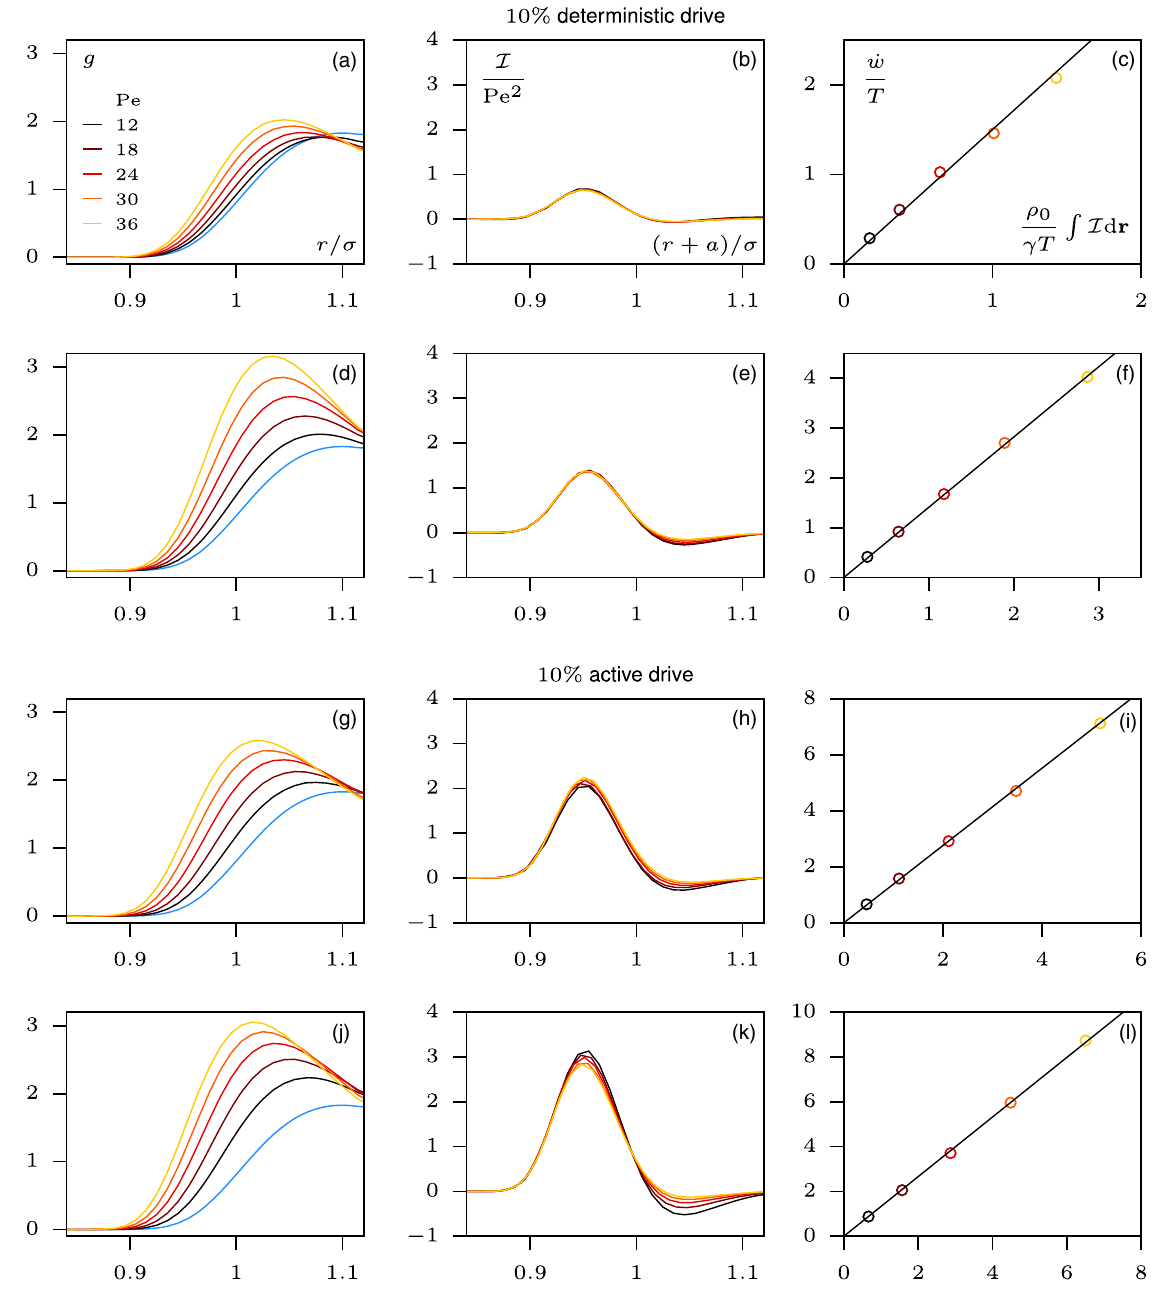
FIG. 3. Connecting dissipation and structure for a liquid where 10% of particles are driven by either deterministic or active forces. (Left) Bath-tracer density correlation g as a function of interparticle distance r= σ . The blue solid line corresponds to the equilibrium correlation function g for Pe ¼ 0 . (Middle) Deviation from equilibrium correlations I ¼ ½ð ∇ v Þ 2 − T ∇ 2 v (cid:2)ð g − g eq function of ð r þ a Þ = σ , where a ð Pe Þ is a fitting parameter. The data almost collapse into a master curve for each row, namely, at a given τ . (Right) Parametric plot of the rate of work _ w=T and the integrated deviation from equilibrium correlations ρ 0 linear relation. The black solid line with slope α is the best linear fit, and the marker colors refer to the same P´eclet values as in the left and right columns. Simulation details are in Appendix A. Parameters: f τ T= ð γσ 2 Þ ; α g ¼ f 2 × 10 − 1 ; 1 . 50 g (a) – (c), f 5 × 10 − 1 ; 1 . 41 g (d) – (f), f 2 × 10 − 2 ; 1 . 38 g (g) – (i), and f 5 × 10 − 2 ; 1 . 33 g (j) –